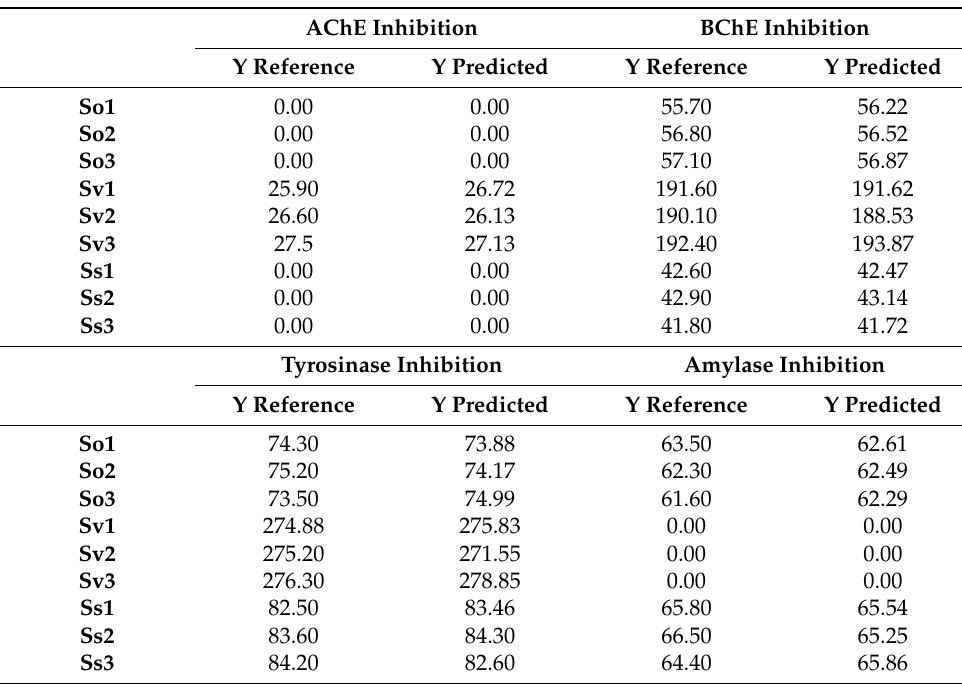
Table 7. Results of calibration and predictive ability of the PLS-R2 model. AChE Inhibition BChE